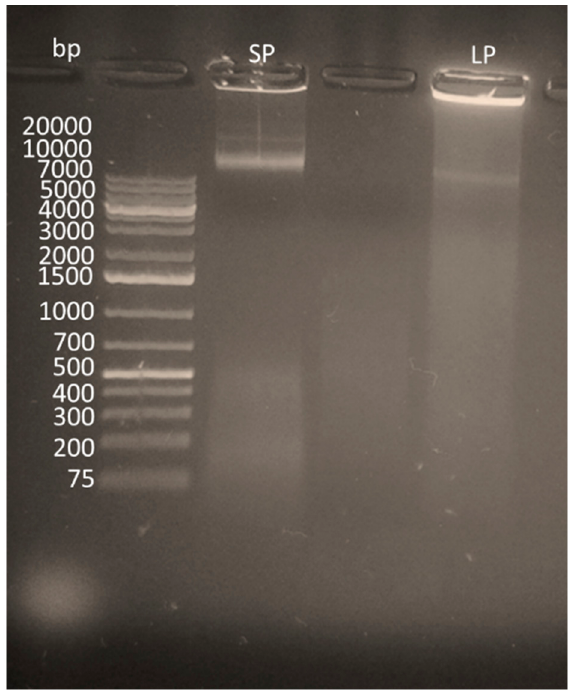
Figure 2. An agarose gel (0.5%) illustrating the lysis on solid-phase (SP) vs. liquid phase (LP).